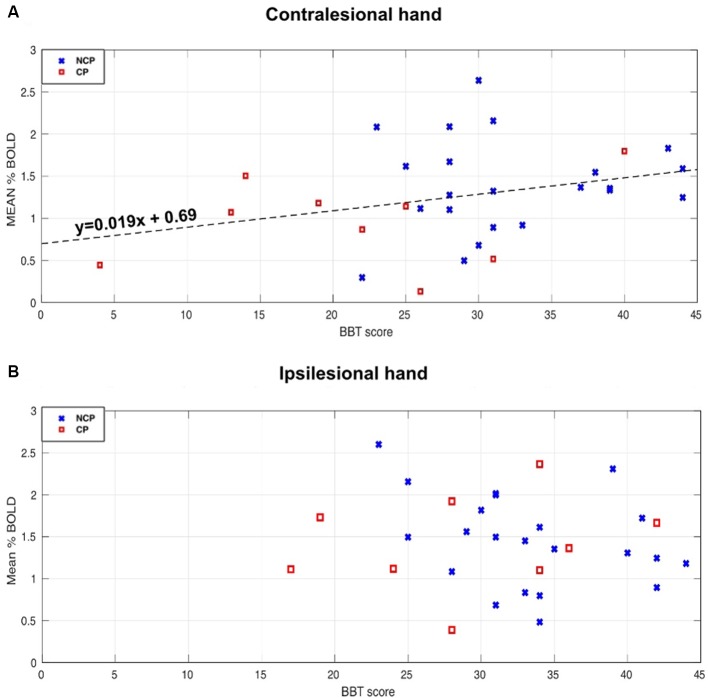
Relationships between Bold signal percentage change and Box and Block Tests (BBT) score for the NCP (blue X) and CP (red square) subjects. (A) Scatterplot of the contralesional BBT score and the mean BOLD amplitude of the lesioned hemisphere when activating the contralesional hand. A significant positive correlation (rho = 0.33, p < 0.05) was found for both groups (CP and NCP). The Dashed line represents the linear fitting for all the subjects. (B) The relationship between the ipsilesional BBT score and the mean BOLD amplitude of the unaffected hemisphere when activating the ipsilesional hand. No significant correlation was found (rho = −0.14, p = 0.45).